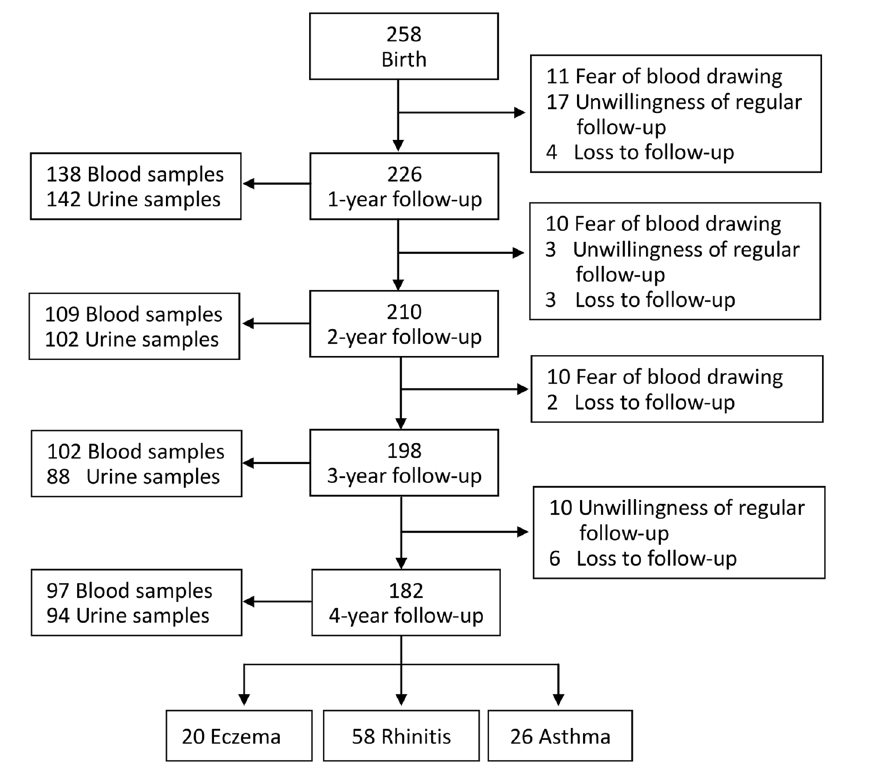
Fig. 1. Schematic presentation of the recruitment process of the study